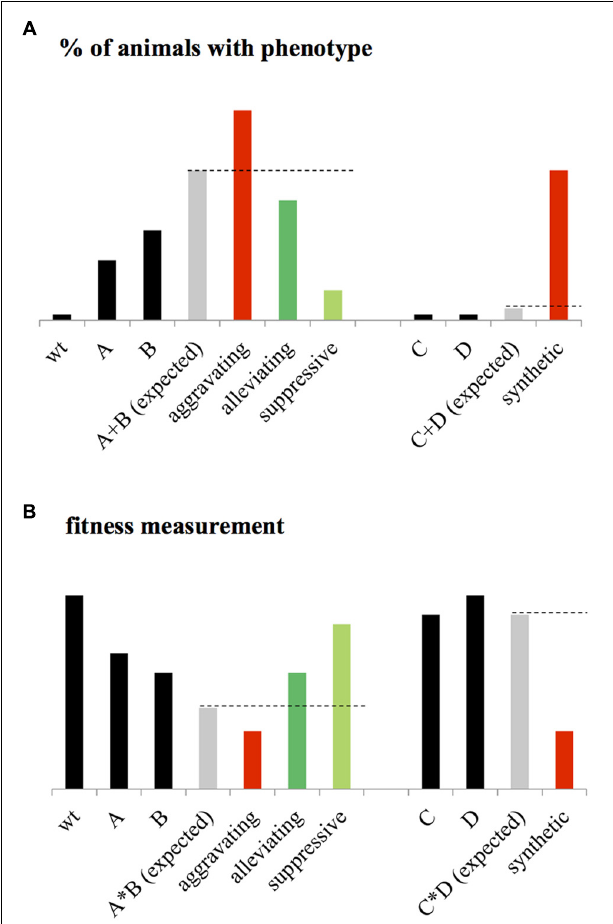
FIGURE 1 | Statistical epistasis. (A) When considering the penetrance of a given phenotype as the percentage of animals expressing this phenotype at a given “significative” level, genetic interactions (GIs) are usually identified using the additive model. Considering the phenotype of wild-type ( wt ) animals, close to zero, the expected phenotype of the double mutant AB corresponds to the sum of the phenotypes of mutant A and B. An aggravating GI between A and B is then identified if the phenotype of AB is significantly higher than the expected. An Alleviating GI is identified if the phenotype of AB is significantly lower than expected. A suppressive interaction is identified if the phenotype of AB is lower than the single mutant with the highest penetrance.When considering two mutants C and D with no observable phenotype, a synthetic interaction is identified if the double mutant CD expresses a significant phenotype. (B) When fitness is measured as a phenotype, the wt animals present high fitness rate, the expected phenotype of the double mutant AB is calculated using the multiplicative phenotype (it could also be the Log or Min) as the product of the fitness level of A and B. An aggravating interaction is then identified if AB is significantly lower than expected. Alleviating is identified if the fitness of AB is significantly higher than expected. Suppressive interaction is identified or if the double mutant is more viable than the sickest single mutants. A synthetic interaction is identified if the double mutant presents a significant fitness defect while the two single mutants are